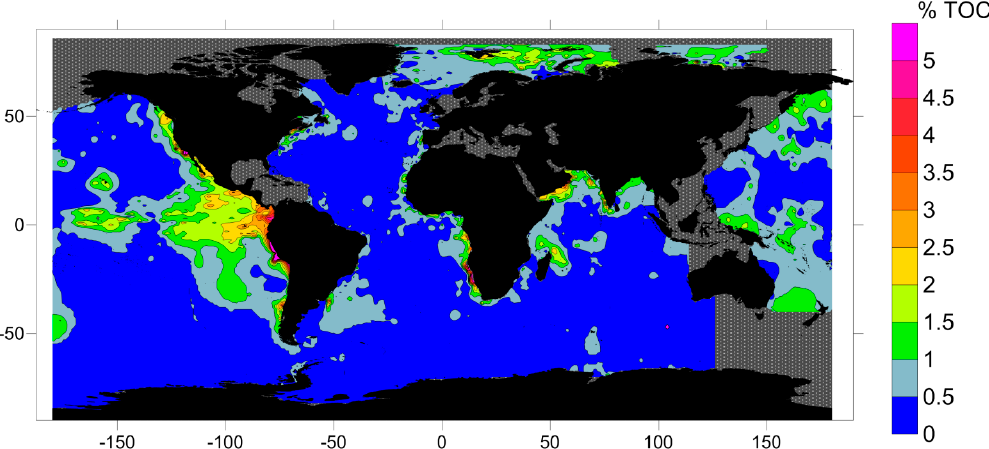
Figure 16. Interpolated sediment TOC concentrations over much of the world ocean.